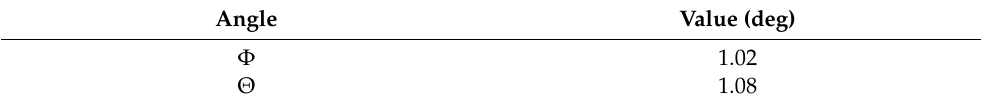
Figure 21. LiDAR calibration during the outdoor tests. Table 5. Inclination angles of the regression line in the outdoor calibration test. Angle Value (deg)